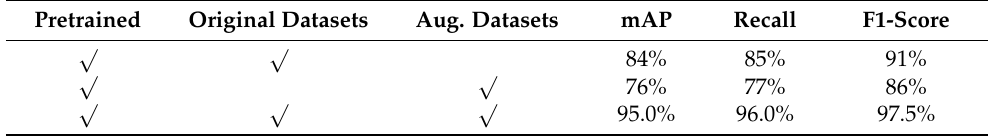
Table 9. Testbed dataset experiment with group (the input size of the image is 1920 × 1080).